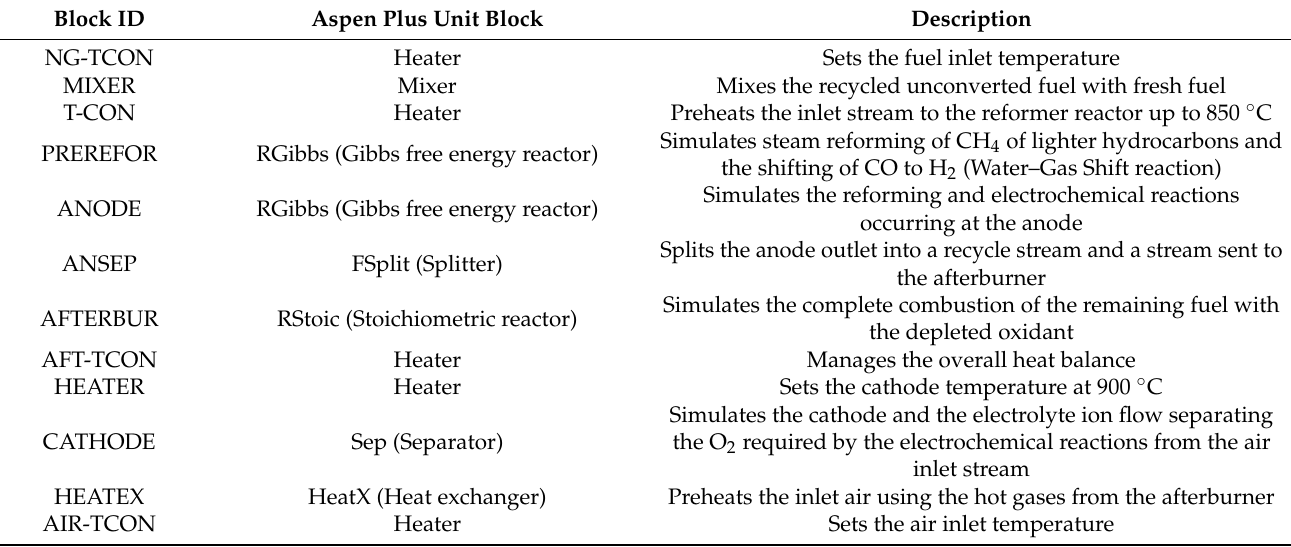
Figure 1. SOFC power generator system flowsheet built-in in Aspen Plus. Table 1. Description of Aspen Plus unit operation blocks of the flowsheet presented in Figure 1.